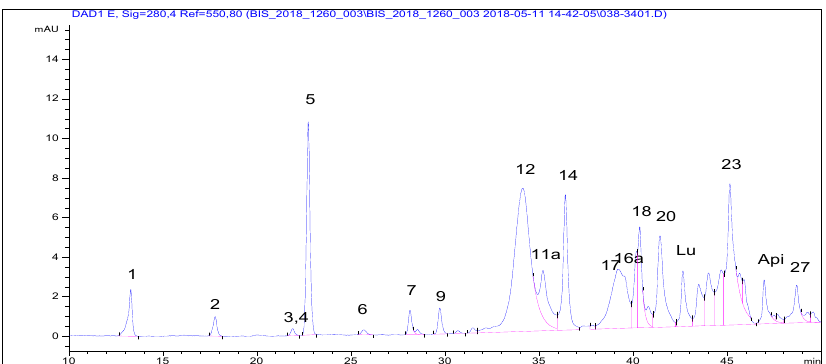
Figure 2. Profile at 280 nm of S-26 VOO PF using UHPLC-diode array detection (DAD; protocol C; 1: Htyr, 2: Tyr, 3: Vanillic acid, 4: Ca ff eic acid, 5: Syringic acid (IS), 6: Vanillin, 7: p